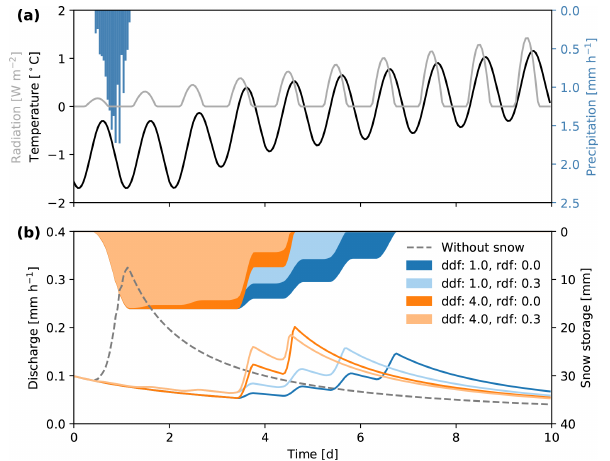
Figure 3. Simulation results with and without the snow conceptual- ization. Top panel shows the model input; bottom panel shows the model output. The four hydrographs represent runs with different snow parameter values (see legend, in mmh − 1 ). We fixed the criti- cal temperature T 0 to 0 ◦ C. To visualize the influence of the different parameters, we used unrealistically high ddf and rdf